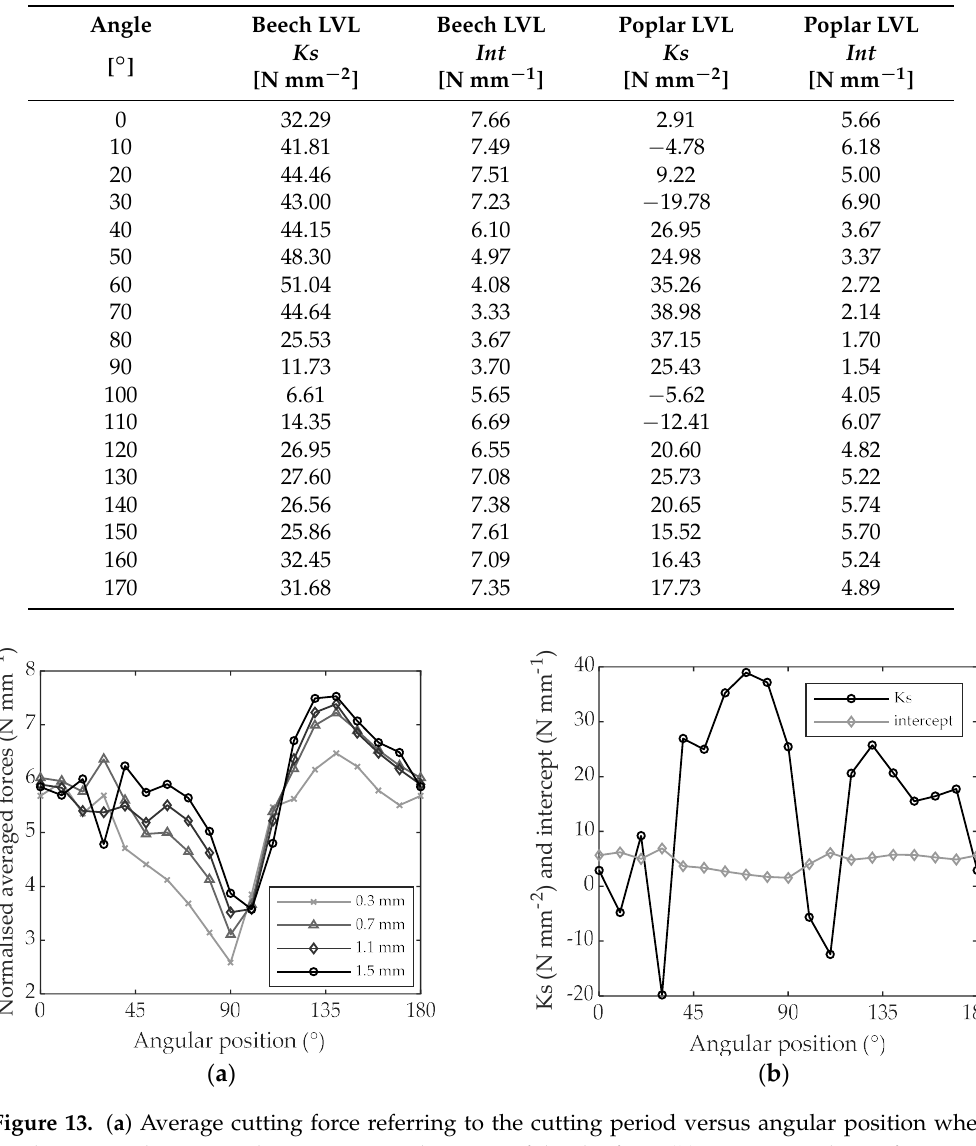
Figure 13. ( a ) Average cutting force referring to the cutting period versus angular position when machining poplar LVL with 0.3, 0.7, 1.1 and 1.5 mm of depth of cut; ( b ) intercept and specific cutting coefficient gathered every 10 ◦ of angular